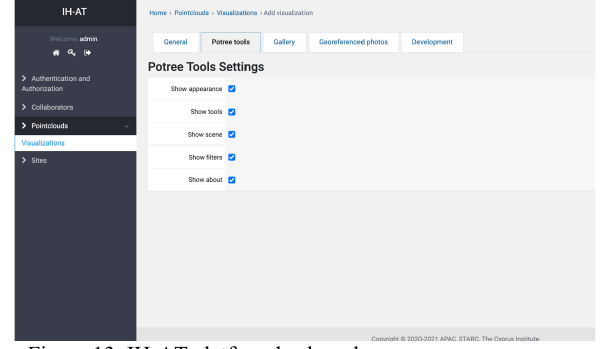
Figure 13. IH-AT platform